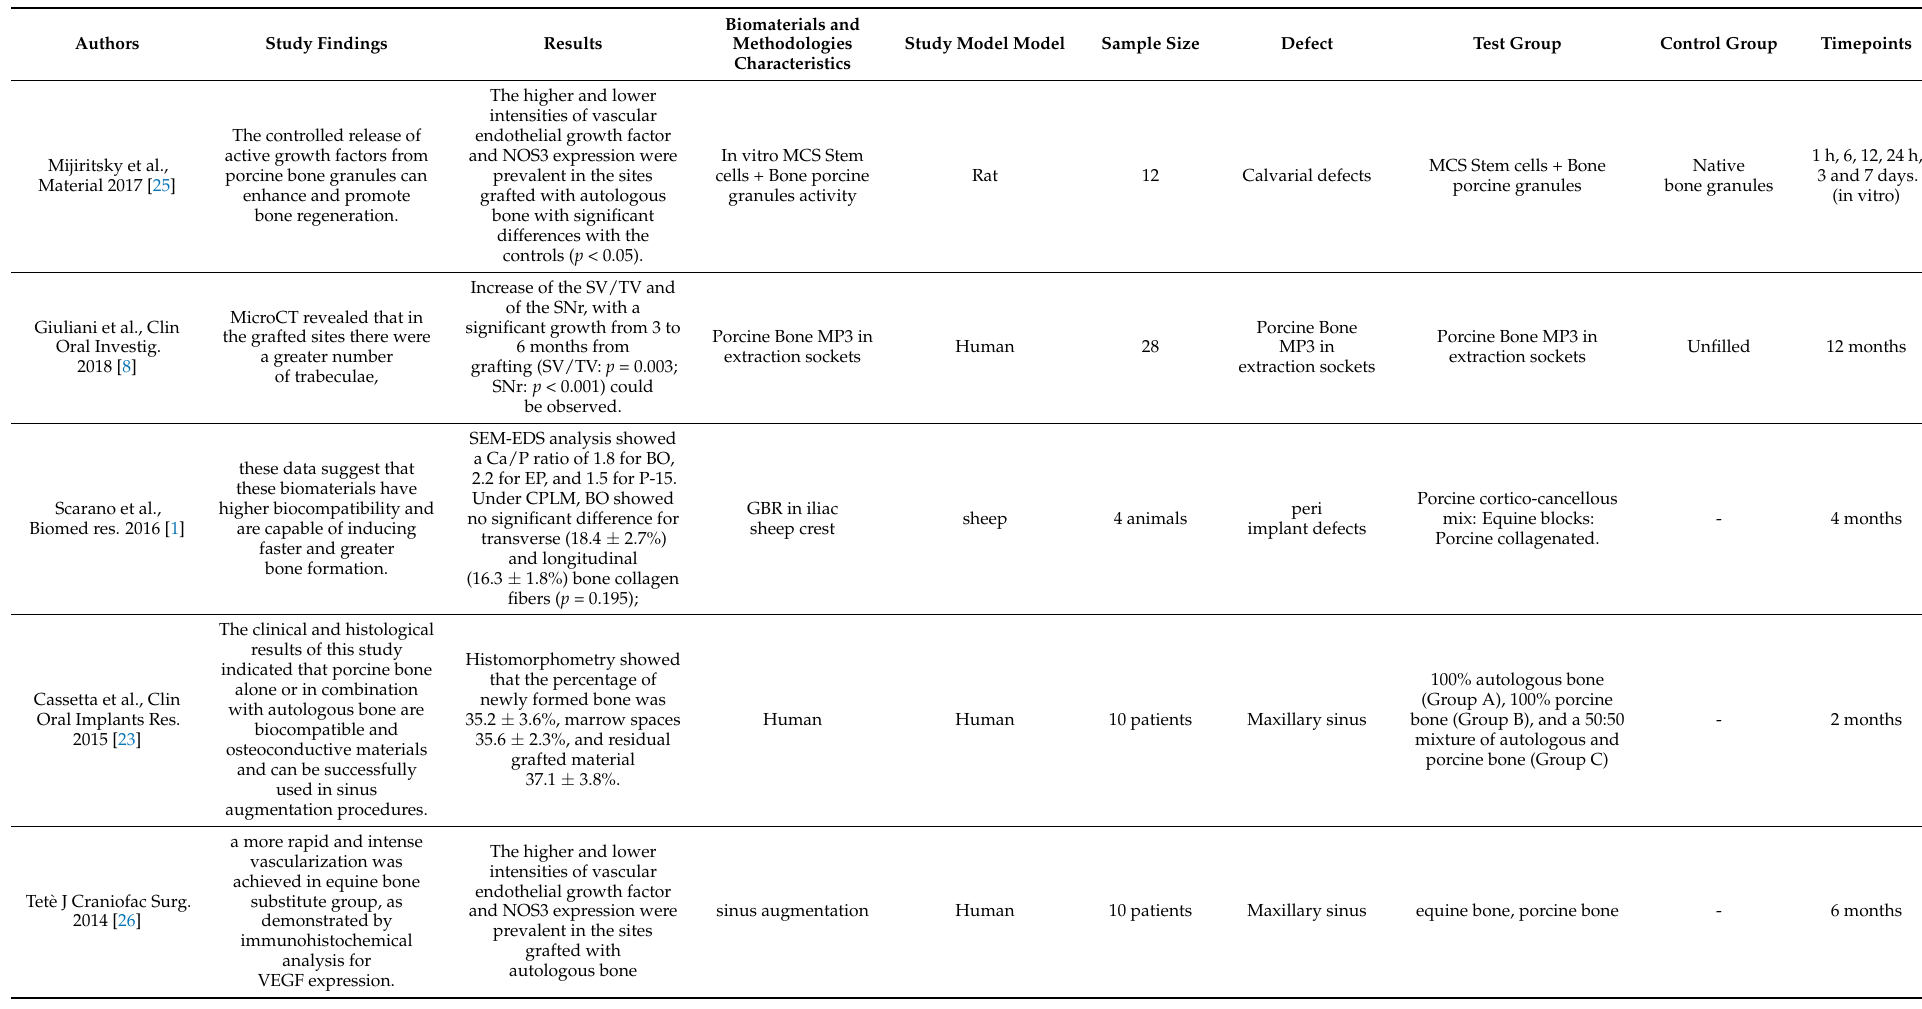
Table 2. Summary table of the porcine bone (PB) findings of the papers